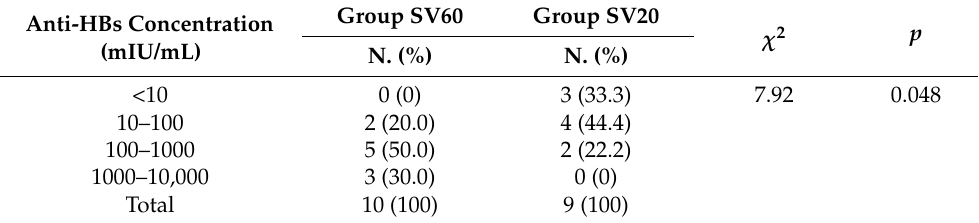
Table 3. Distribution of anti-HBs concentration after revaccination of non-responders in diabetic